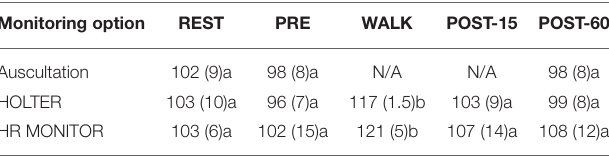
TABLE 1 | Mean ( ± SD) HR of all monitoring options at different timepoints ( N = 8 dogs). Monitoring option